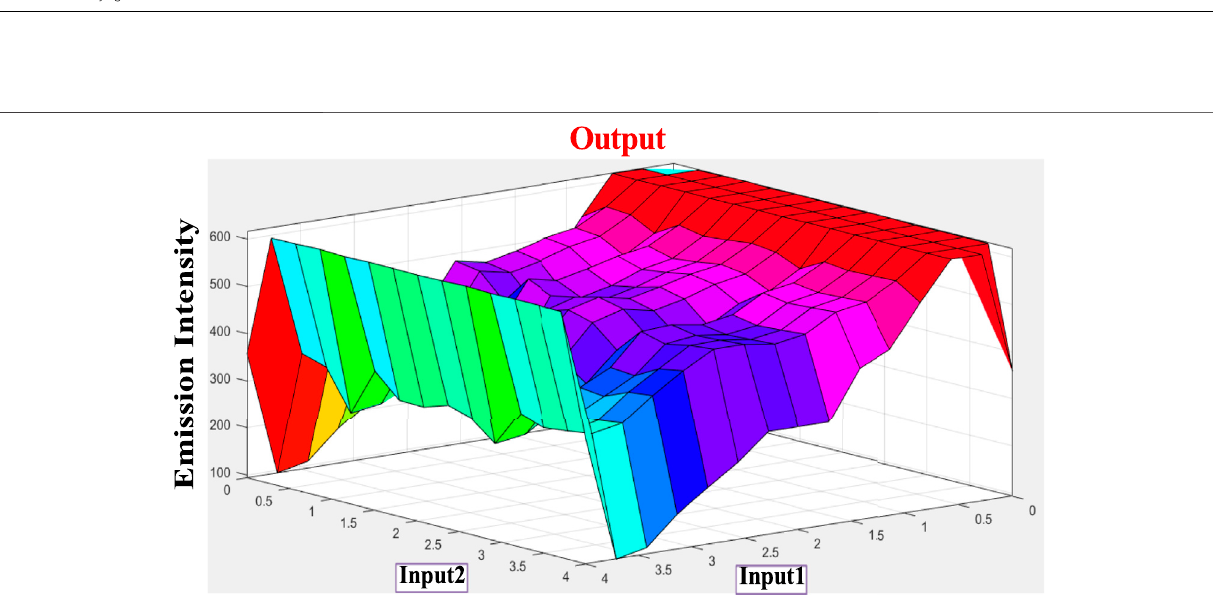
Frontiers in Chemistry |